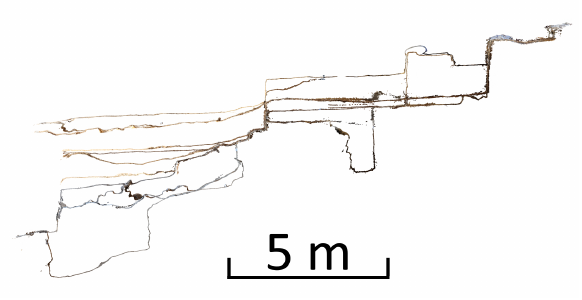
Figure 5. Longitudinal section